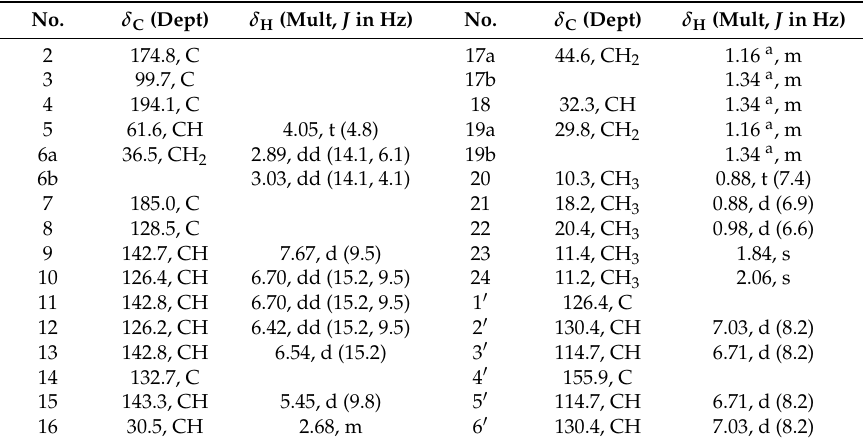
Table 1. 1 H (600 MHz) and 13 C (150 MHz) NMR data of compound 1 (in CD 3 OD). No. δ C (Dept) δ H (Mult, J in Hz) No. δ C